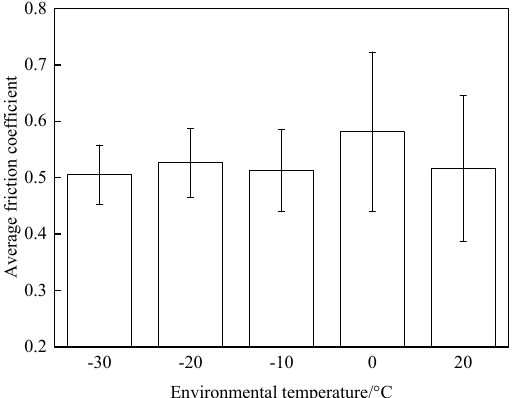
Figure 5. Average friction coefficient histogram.